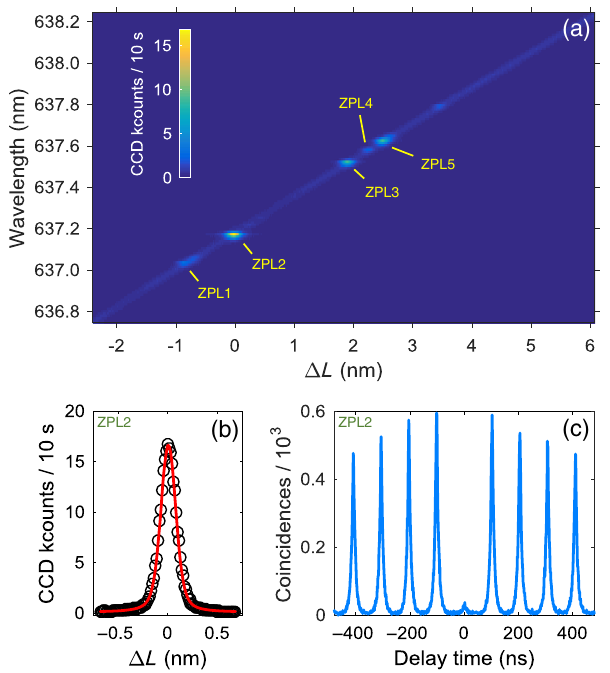
FIG. 2. (a) PL spectra around the ZPL transition for different air-gap detunings Δ L about L ¼ 1 . 96 μ m. Each resonance corresponds to the ZPL emission of a single NV center, as labeled. The PL is excited using a pulsed supercontinuum laser source ( P ∼ 10 mW, λ ¼ 560 (cid:2) 20 nm) and detected by a grating spectrometer. (b) Integrated PL versus L for ZPL2 along ¼ 60 . 6 pm). with a Voigt fit (FWHM Lorentzian contribution Γ L Together with the cavity dispersion in (a), Γ determines the L cavity Q -factor, Q ¼ λ = Γ λ ¼ λ = ð Γ · d λ = d L Þ ¼ 58 500 . (c) Pho- L ton autocorrelation [ g ð 2 Þ ð t Þ ] measurement on ZPL2 exhibiting a clear single-photon emission g ð 2 Þ ð 0 Þ ¼ 0 . 27 . The ZPL emission is filtered ( 637 (cid:2) 7 nm) and analyzed via a Hanbury Brown- Twiss setup (integration time: 45 000